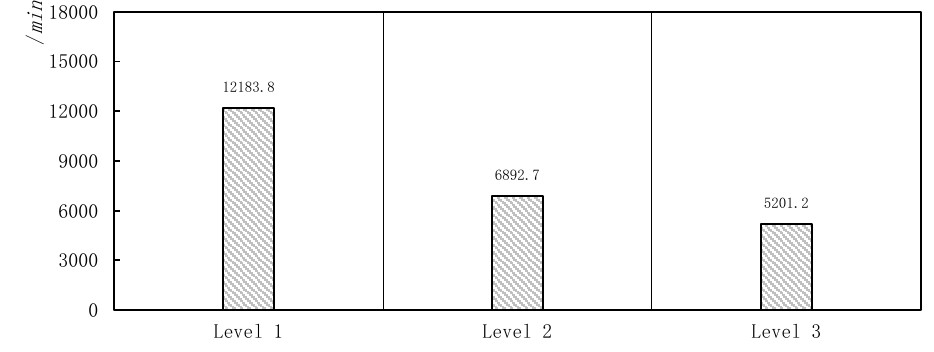
Figure 3. Comparison of the total trip time of the three types of charging stations. Table 8. Comparison of the energy recharged for each OD pair.